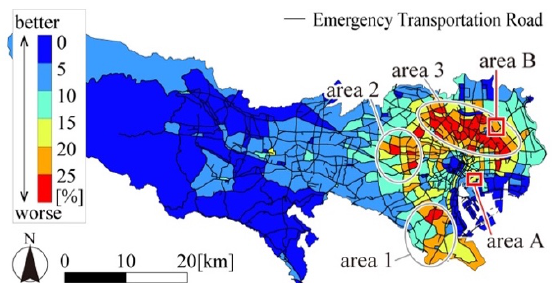
Figure 7. Spatial distribution of street blockage risk (emergency vehicles cannot pass, passible width: 4m)